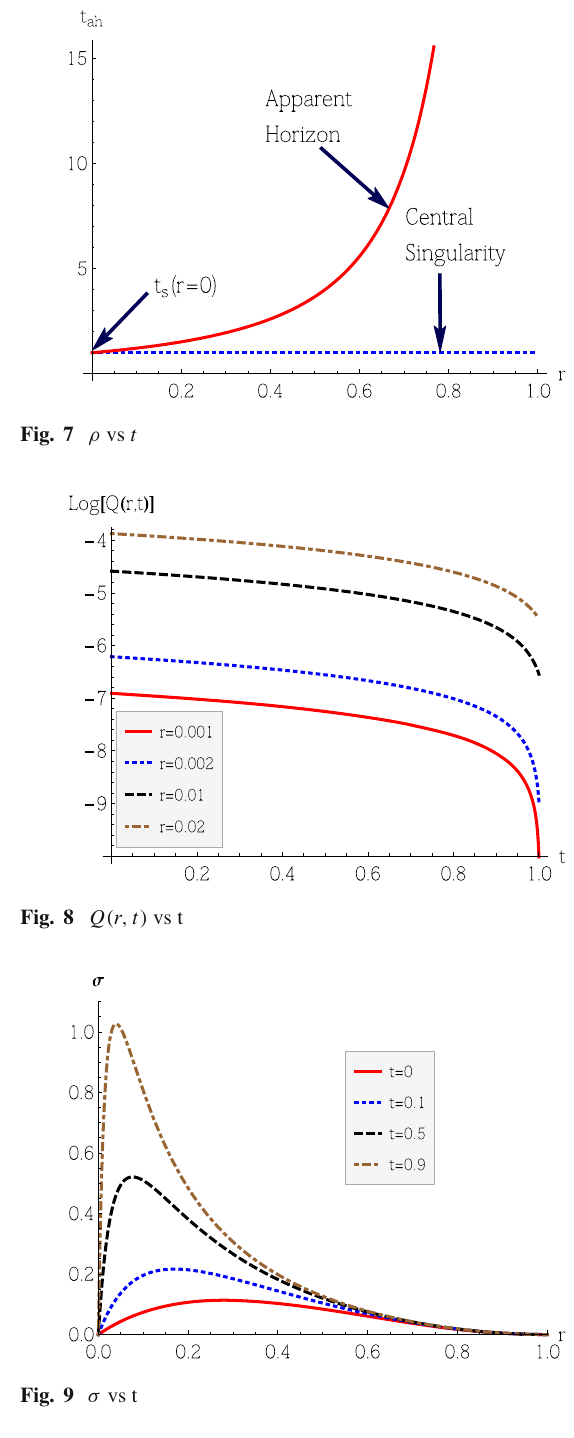
blue line is the time of formation of the central singularity, i.e t s ( r = 0 ) = 1. Clearly, all co-moving observers will see the formation of the central singularity first, and there- fore conclude that the collapse results in a singularity that is locally naked. In Fig. 8, we show the logarithm of Q ( r , t ) as a function of time. Here, the thick red, dotted blue,